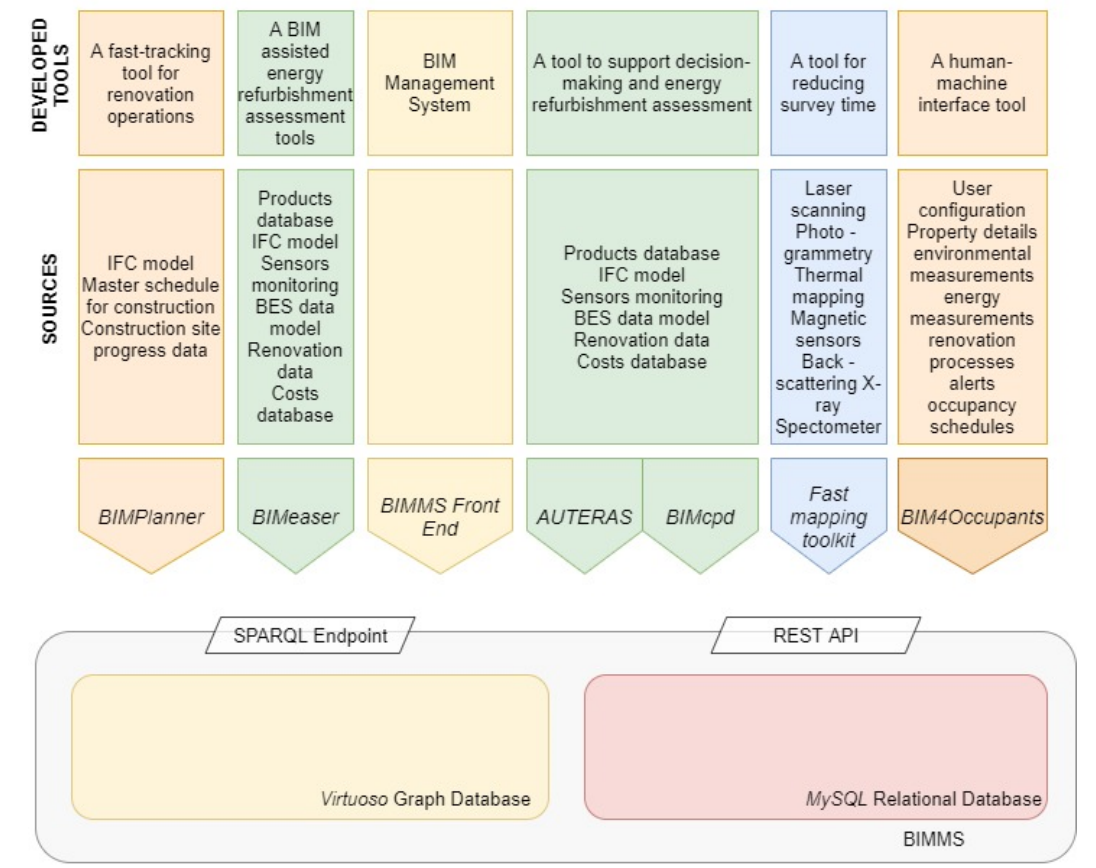
Figure 2. General overview of the BIM4EEB toolkit.